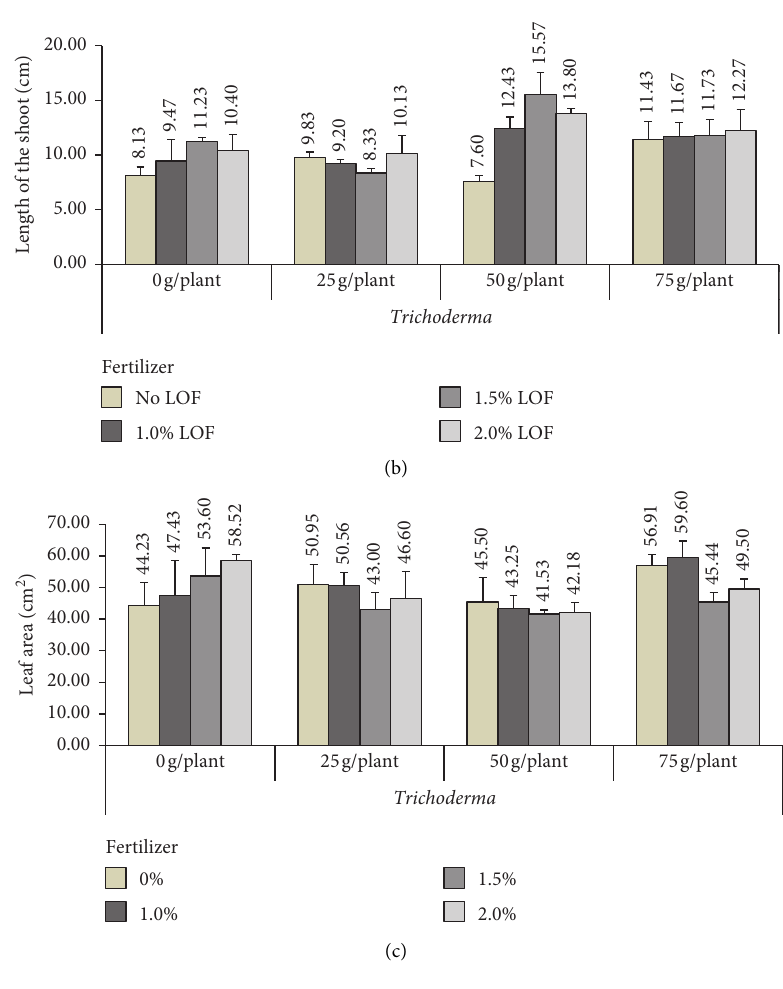
Figure 6: Effect of the combination treatment of Trichoderma and foliar fertilizer application on emergence time of the shoot (a), length of the shoot (b), and leaf area (c) of black pepper seedlings (after 8 weeks of planting). Vertical bars represent SE.